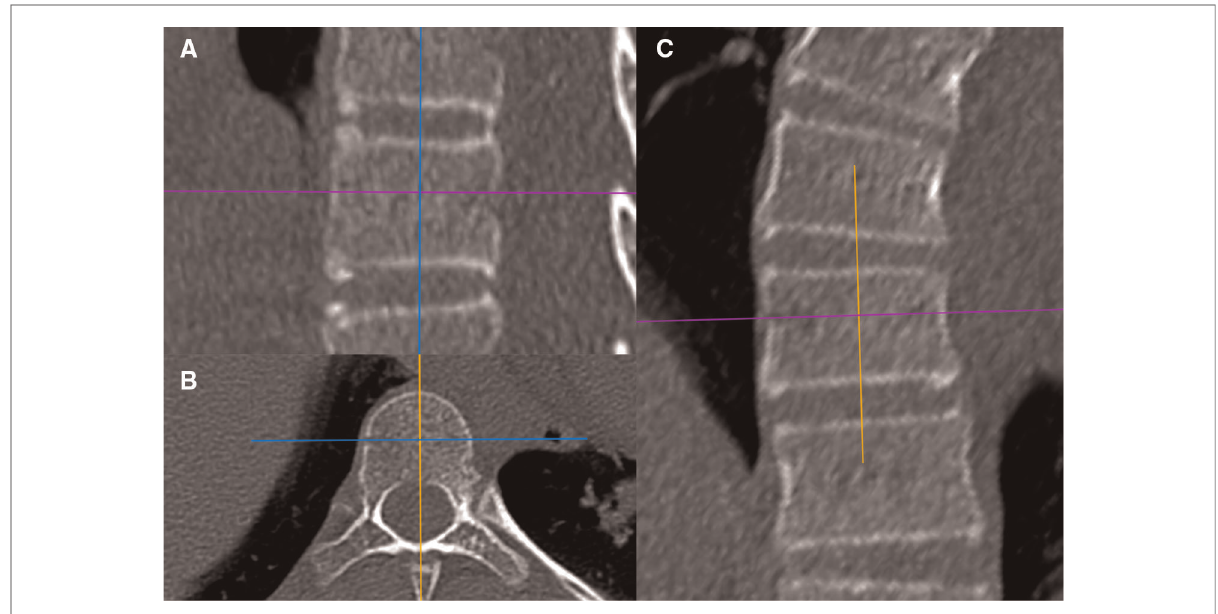
FIGURE 1 Schematic diagram of the sagittal slicing plane ( A ), the transverse slicing plane ( B ), and the coronal slicing plane ( C ).